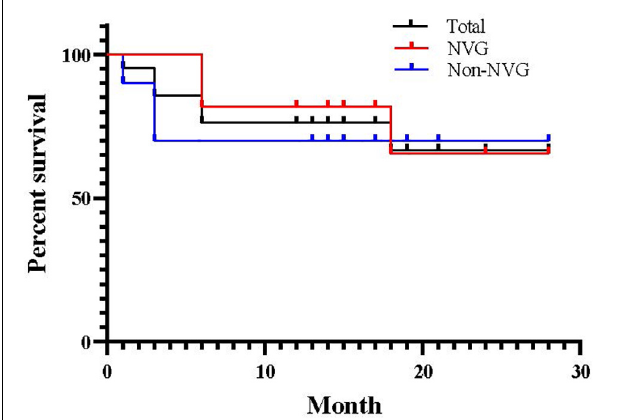
FIGURE 3 | Kaplan–Meier survival curve for success after pars plana Ahmed valve implantation. Success was defined as 8 mmHg ≤ postoperative intraocular pressure ≤ 21 mmHg without